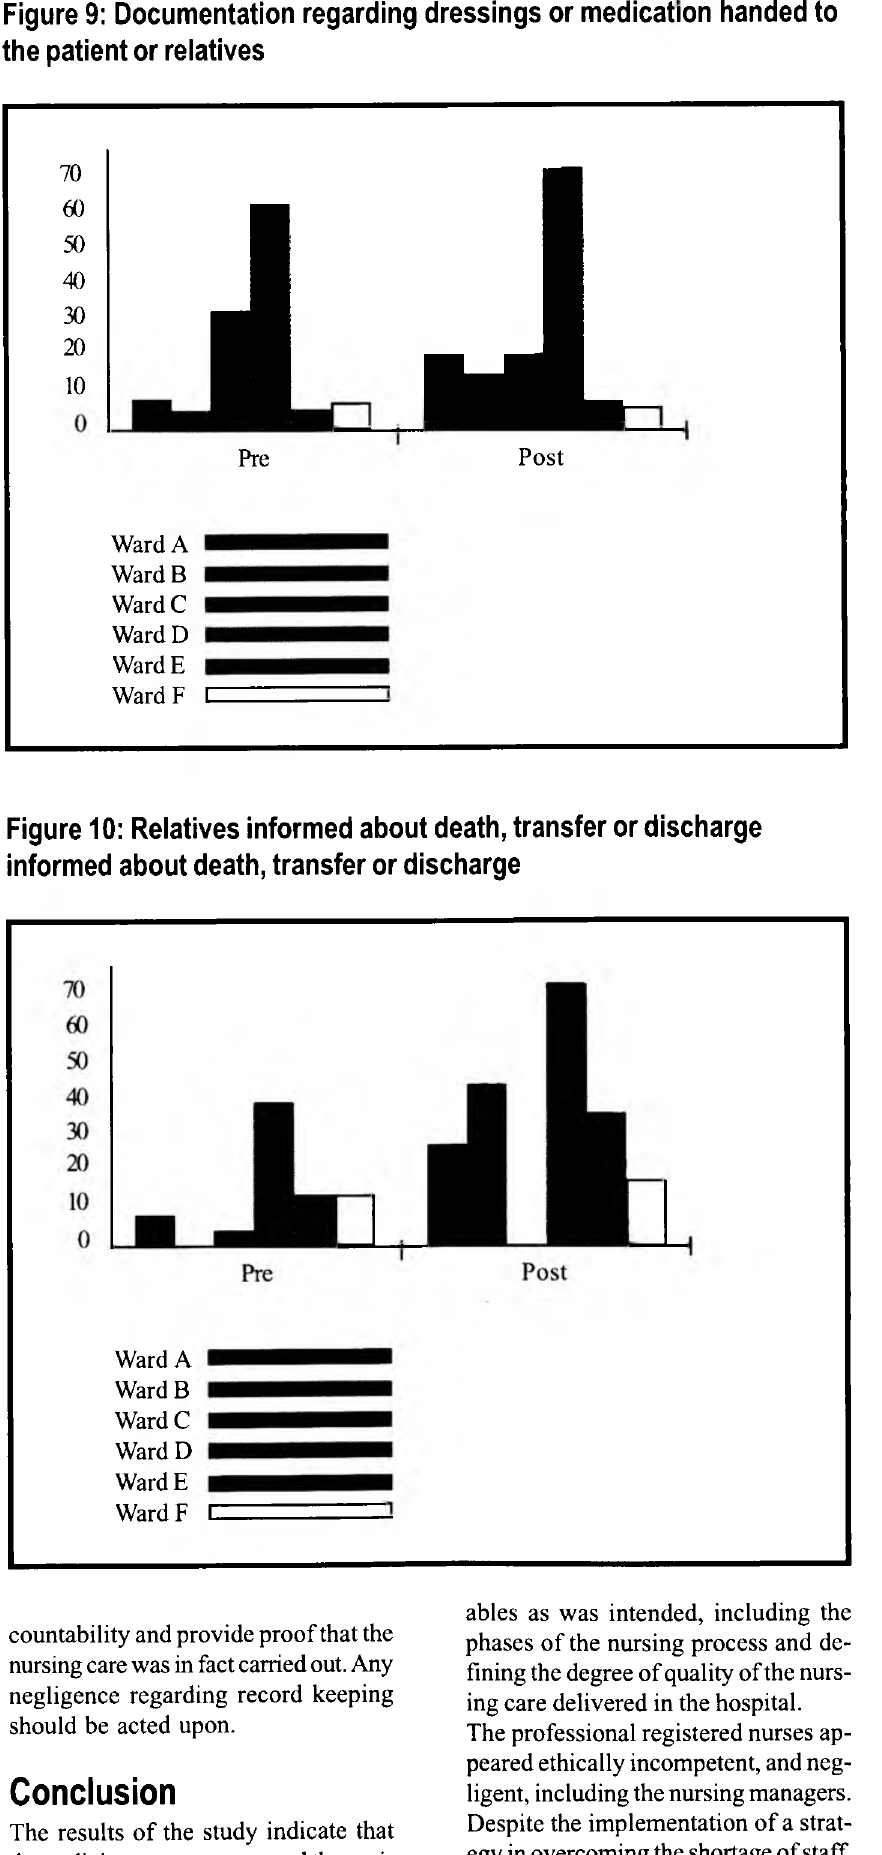
Figure 9: Documentation regarding dressings or medication handed to the patient or relatives